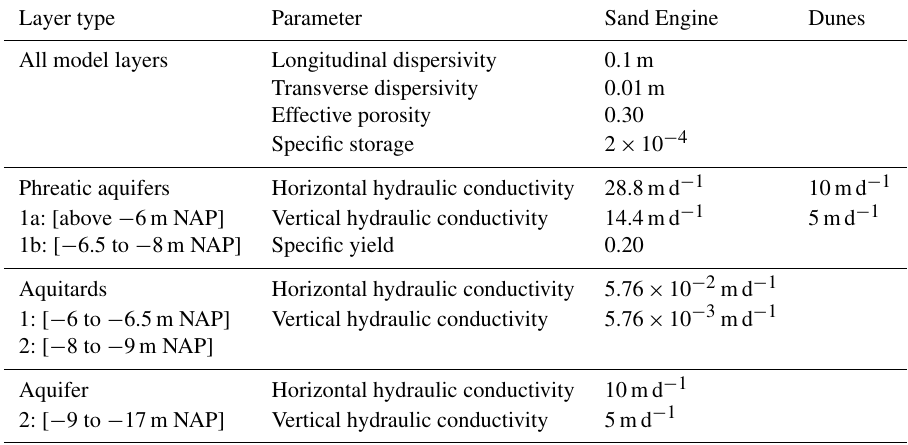
Table 1. Calibrated parameter values implemented in the model simulations.